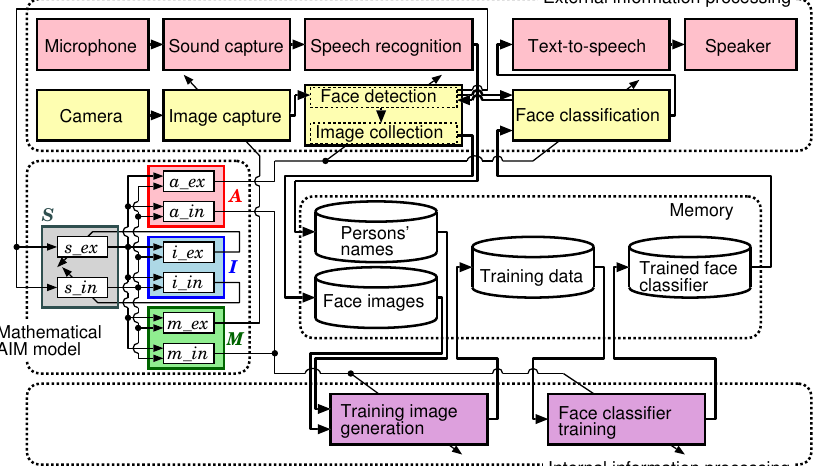
Figure 7. Block diagram of the AIM model and processes for face memorization